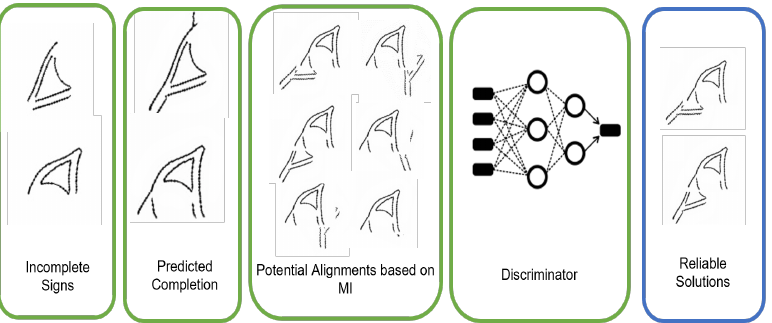
Figure 12. Step-by-step process to register two incomplete signs using the proposed MI-based approach.